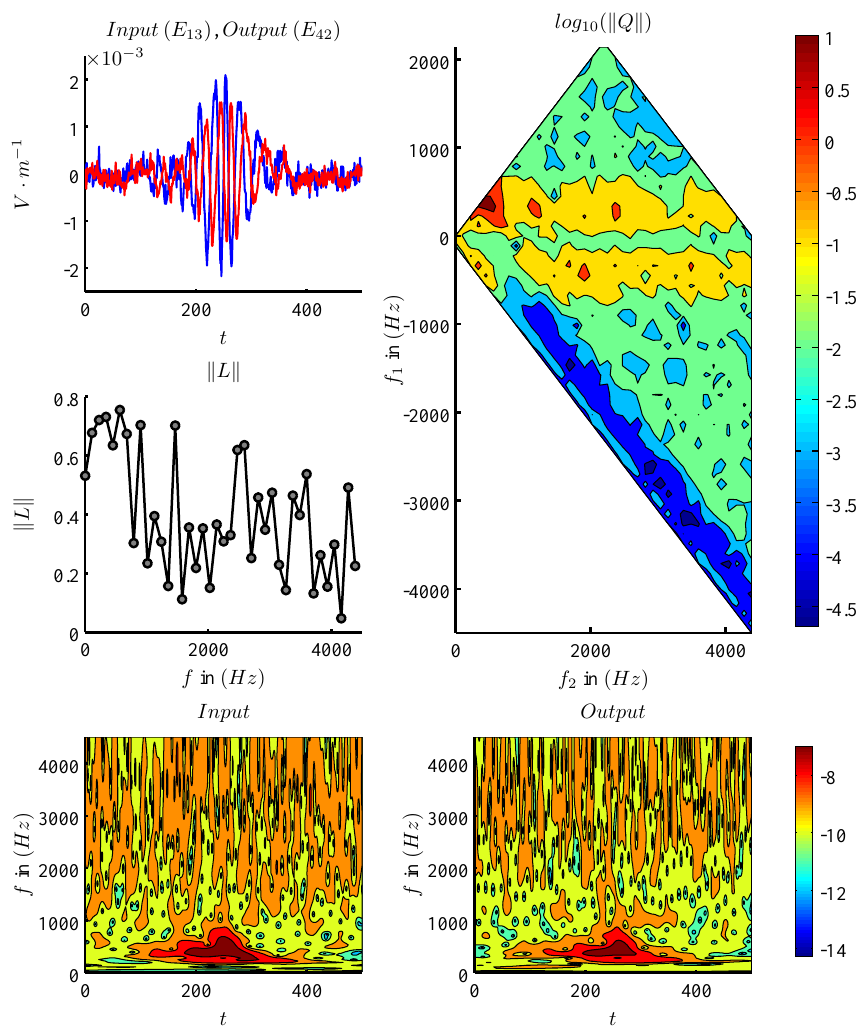
Fig. 2. Wave packet observed at 21:34:01:700 on 26 February 2002. The Input-Output electric fields (top left). The estimated linear transfer function (left middle). The estimated quadratic transfer function (top and middle right). The input ( E 13 ) CWT (bottom left) and the output ( E 42 ) CWT (bottom